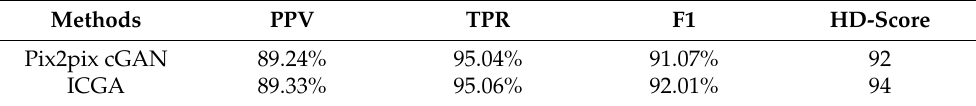
Table 1. Quantitative evaluations on the Dashboard image